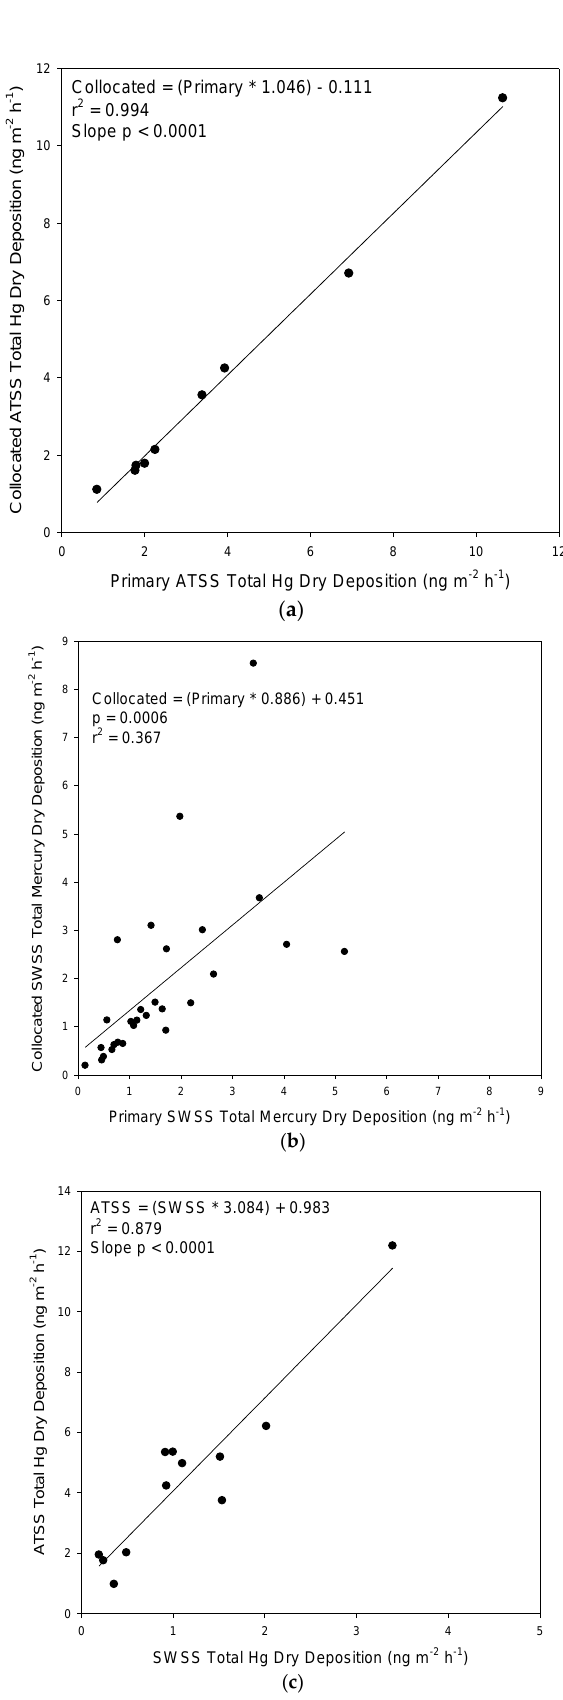
Figure 2. ( a ) Collocated Artificial Turf Surrogate Surface (ATSS) results; ( b ) Collocated Static Water Surrogate Surface (SWSS) results; and ( c ) Artificial Turf Surrogate Surface (ATSS) versus the mean of collocated Static Water Surrogate Surface (SWSS) Collector results for total Hg Dry deposition